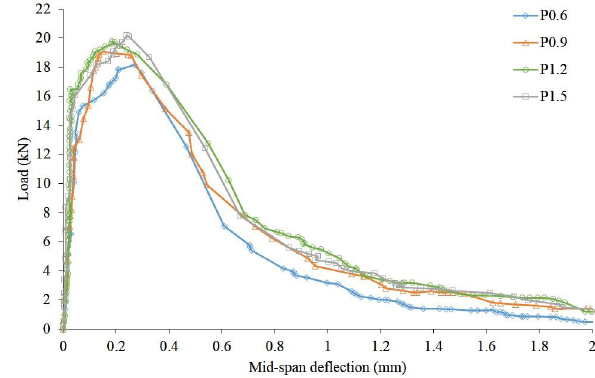
Where f (MPa) is equivalent bending strength at peak e , p load; b (mm) is width of beam; h (mm) is thickness of beam; L (mm) is support span; δ (mm) is deflection of p peak load; Ω (N·mm) is area under load-deflection curve p before peak load; f (MPa) is bending strength of speci- ftm men.